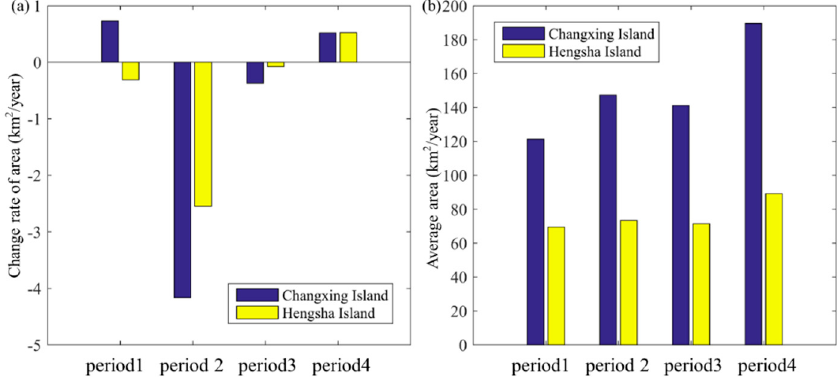
Figure 10. Change rates ( a ) and average values ( b ) of land area in Changxing Island and Hengsha Island during different sub-periods.